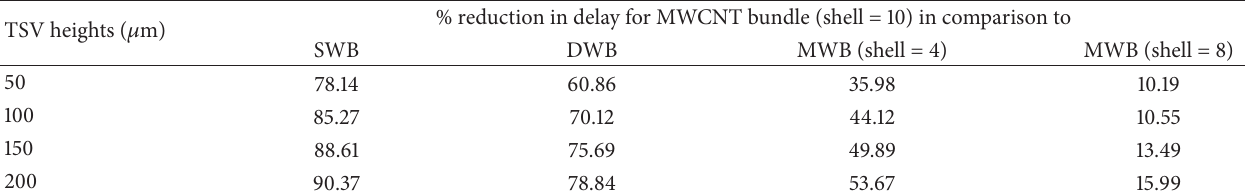
Table 3: Percentage reduction of out-phase delay for 10-shell MWCNT bundled TSV w.r.t. SWCNT, DWCNT, and 4-shell and 8-shell MWCNT bundle based TSVs.